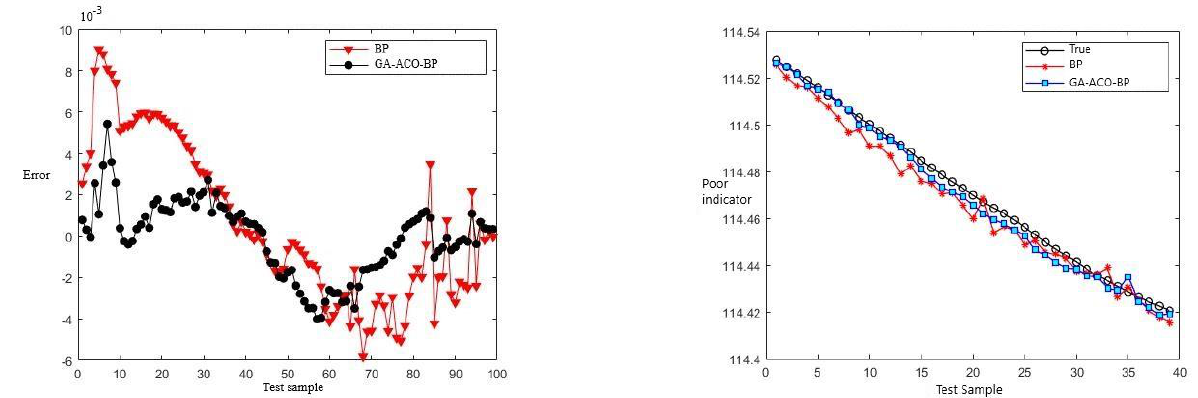
Figure 6. Longitude prediction error and comparison (GA-ACO-BP).